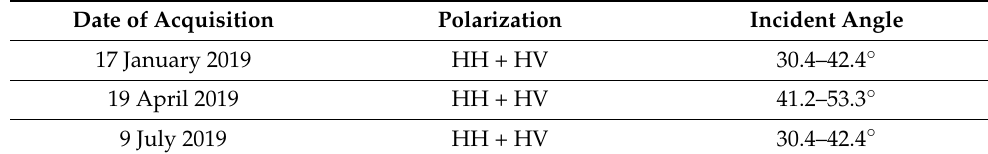
Table 1. PALSAR-2 satellite image acquisition and incident angle.